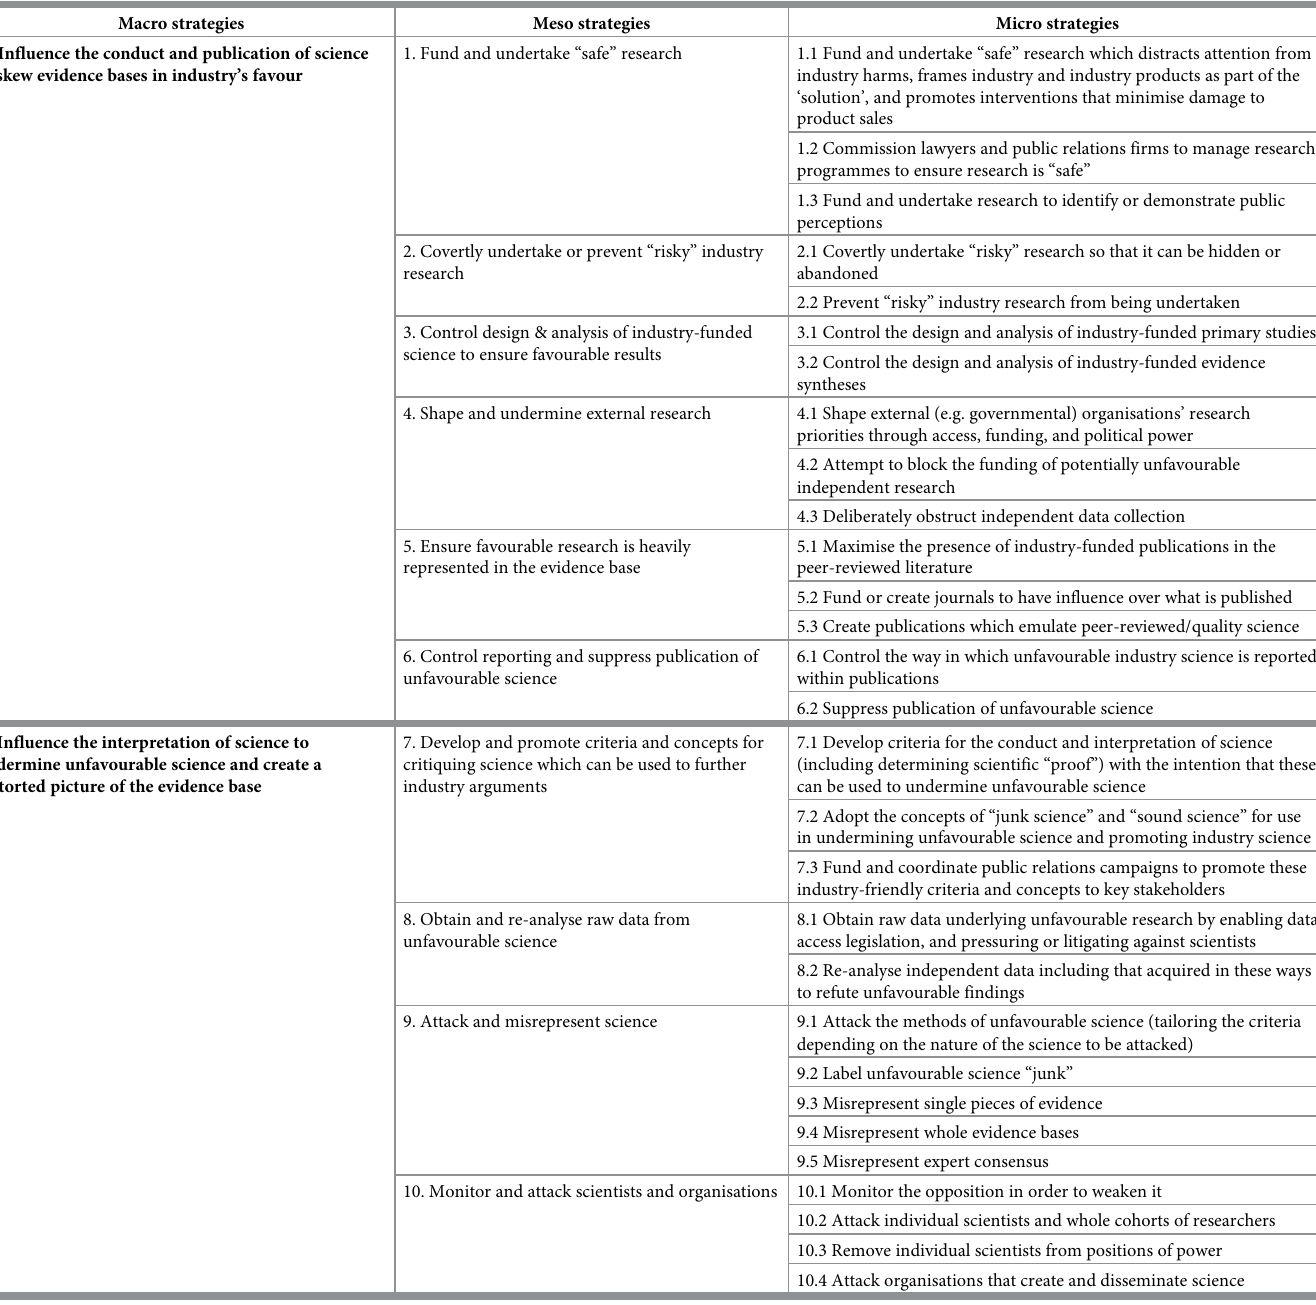
Table 1. The Science for Profit Typology—Macro, meso and micro strategies used by industry to influence science and the use of science in policy and